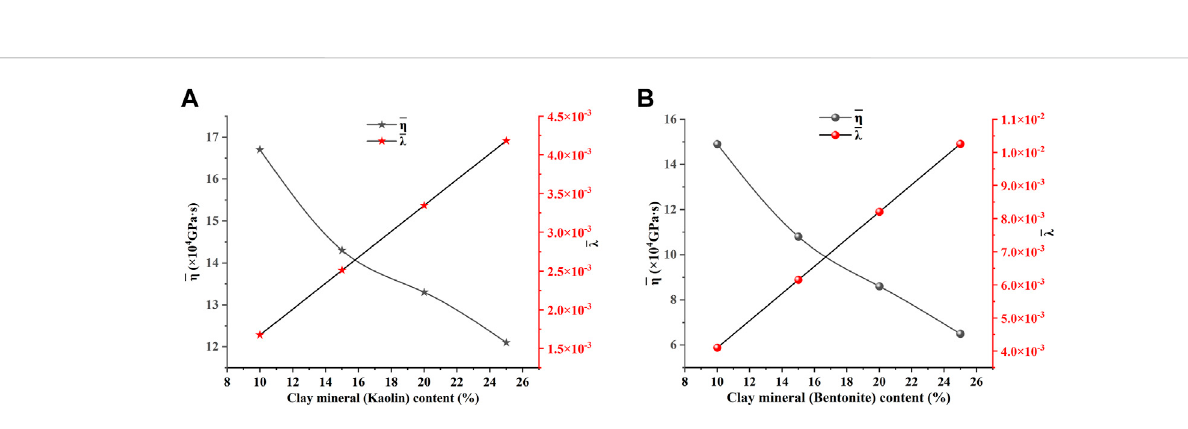
FIGURE 8 Relationship curves between λ and the average viscosity coef fi cient. (A) Kaolin; (B) bentonite.